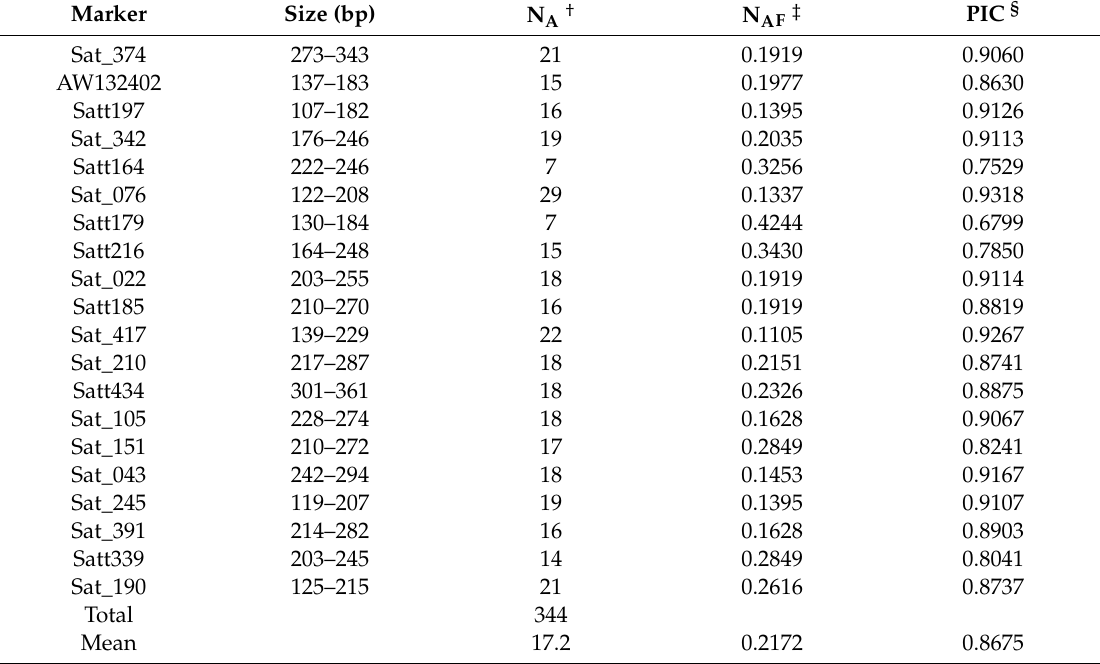
Table 3. Linkage group analysis of 20 simple sequence repeat (SSR) markers used for genotyping in 172 Korean soybean varieties.